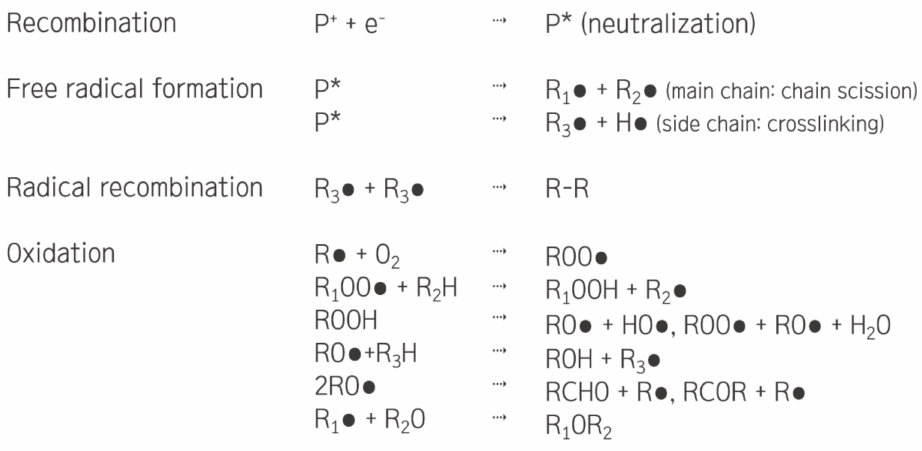
Figure 2. Secondary reactions in polymer materials by gamma irradiation.